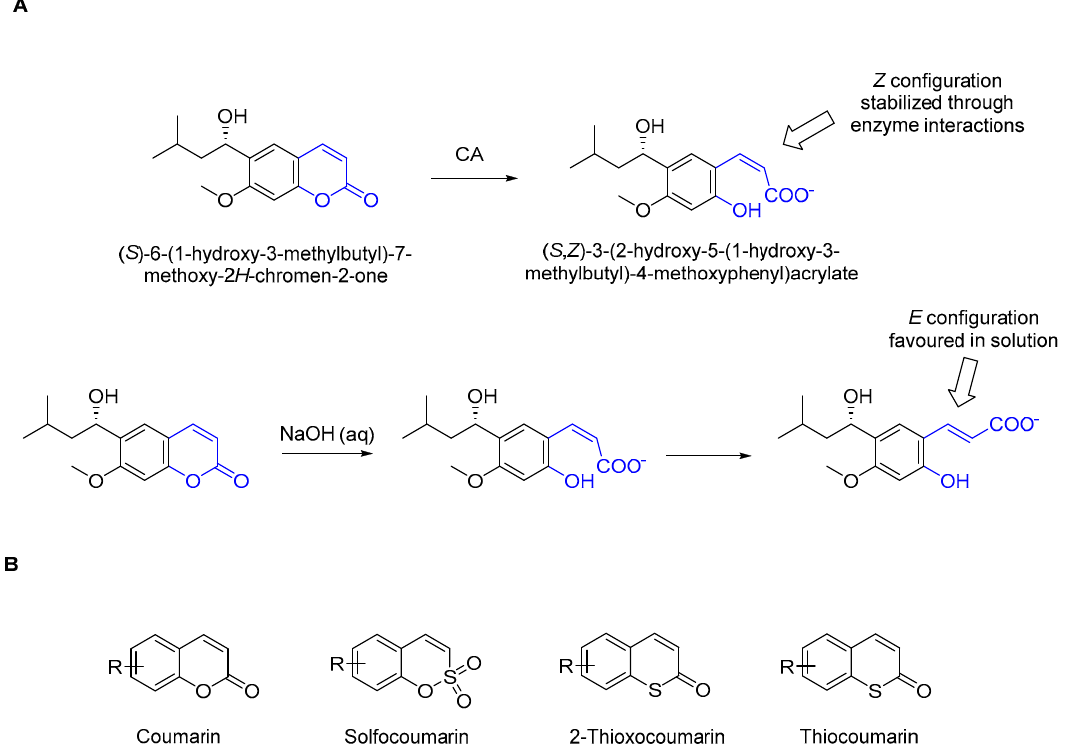
Figure 1. ( A ) Mechanism of action of 6-(1 S -hydroxy-3-methylbutyl)-7-methoxy-2 H -chromen-2-one. ( B ) Coumarin analogues.